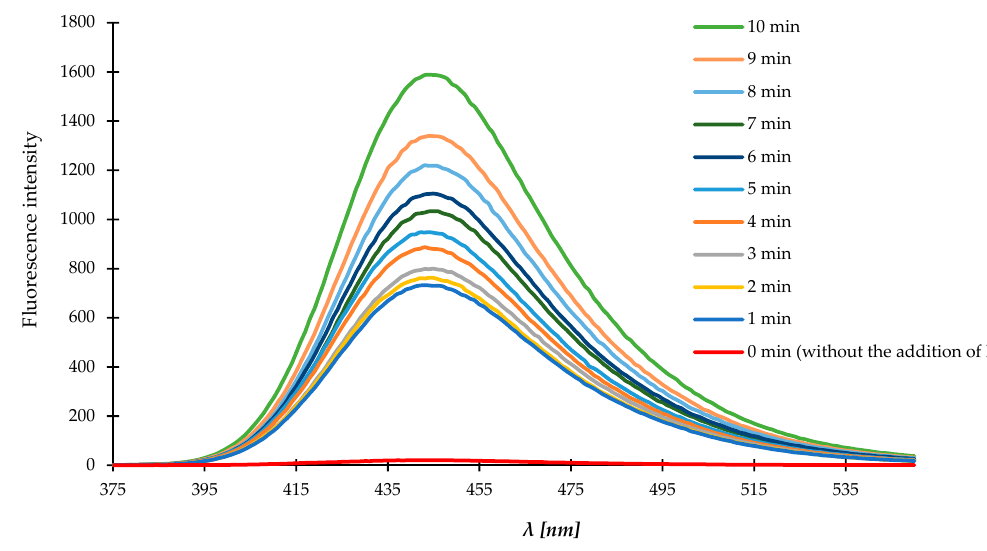
Figure 8. Fluorescence response of the self-immolative probe/compound 1 (0.1 mM) to 0.1 mM NaHS. Data were acquired at room temperature in sodium phosphate buffer (pH = 7.4) with excitation at 365 nm. Emission was collected in the time range 1–10 min after the addition of 0.1 mM NaHS. The spectrum at t = 0 min was acquired from a 0.1 mM solution of the compound 1 without the addition of NaHS.